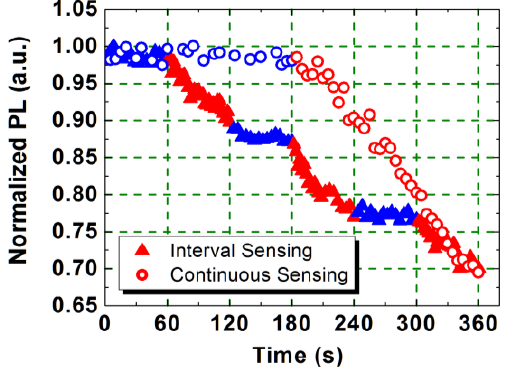
Figure 4. Both interval (triangles) and continuous (open circles) PL sensing with a 340 nm thick PIM film (red highlights sensing, blue highlights clean nitrogen purge).